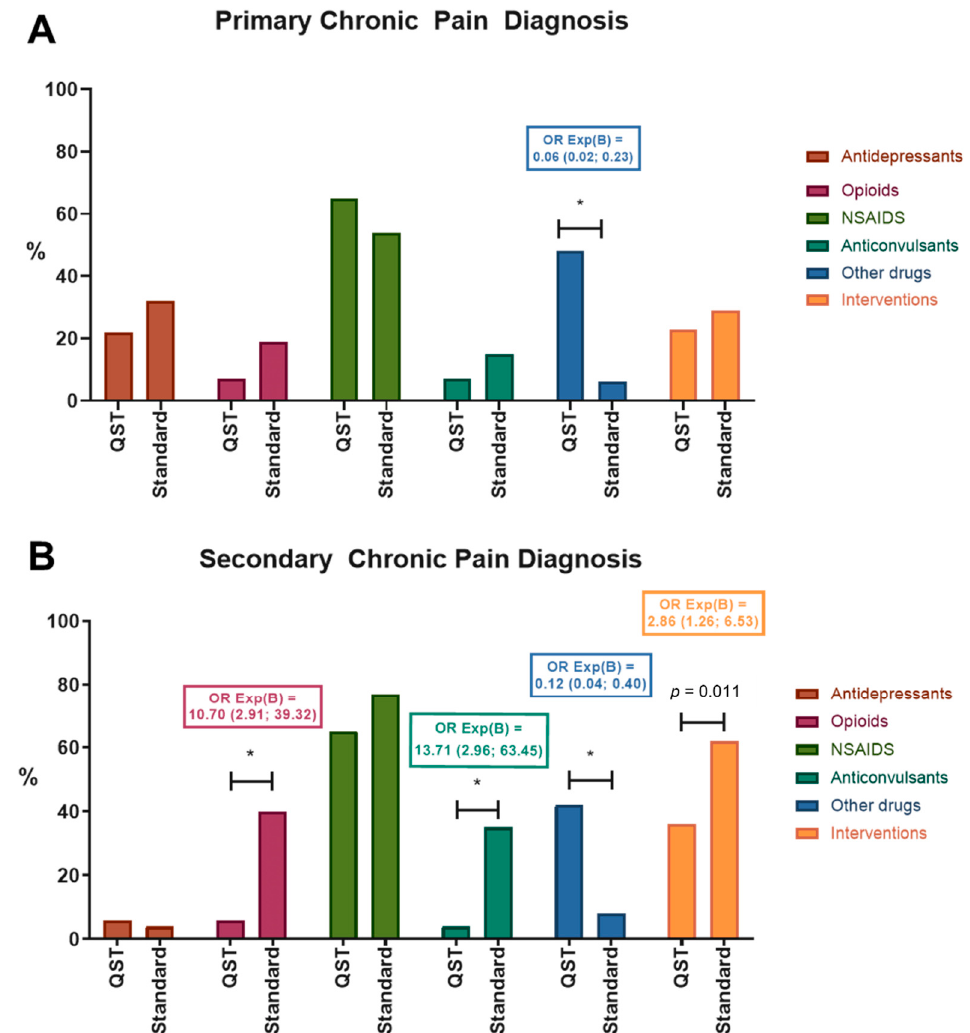
Figure 4. Medical treatment prescribed at the initial visit by chronic pain category and QST